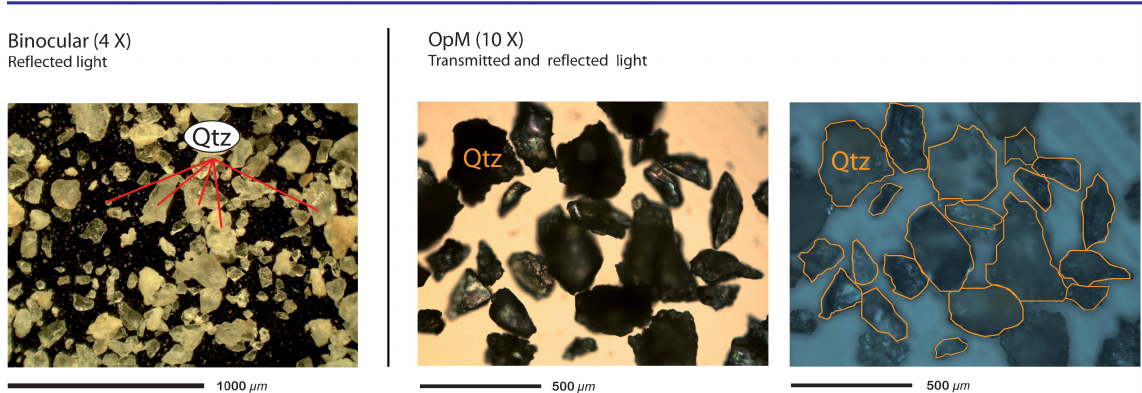
Figure 7. Photomicrographs by binocular microscope (reflected light) and by optical microscope (transmitted and reflected light) of the residue that remained in the reactor chamber after the